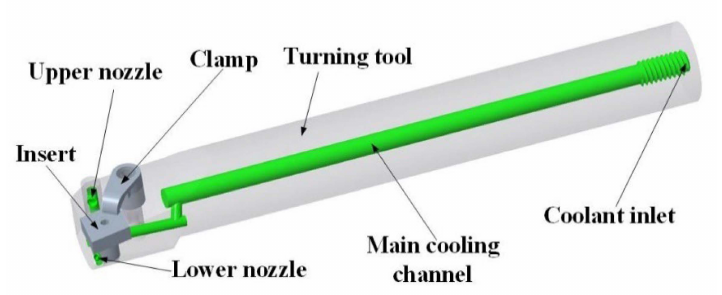
Figure 1. The structure schematic of internal spray cooling turning tool.